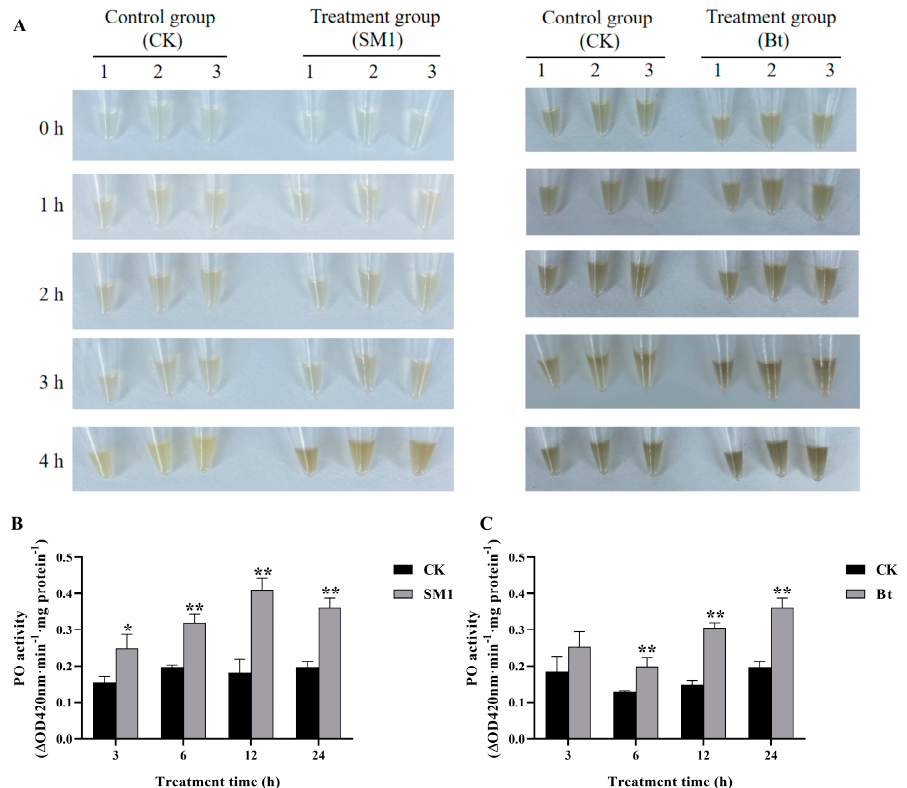
Figure 1. The melanization and enzymatic activity of PO in O. formosanus treated by SM1 and Bt. ( A ): The level of melanization in the hemolymph of O. formosanus infected with bacteria treated for 0, 1, 2, 3 and 4 h. The treatment groups were treated with SM1 or Bt. The control group was treated with culture medium (CK). The melanization reaction was recorded by photography at different time points from 0 to 4 h. ( B ): PO activity in O. formosanus infected by SM1. The control group was treated with culture medium (CK). ( C ): PO activity in O. formosanus infected by Bt. The control group was treated with culture medium (CK). The data are presented as the mean ± SD of three replicates. The asterisks indicate significant differences between the treatments groups and the control groups (* p < 0.05, ** p <